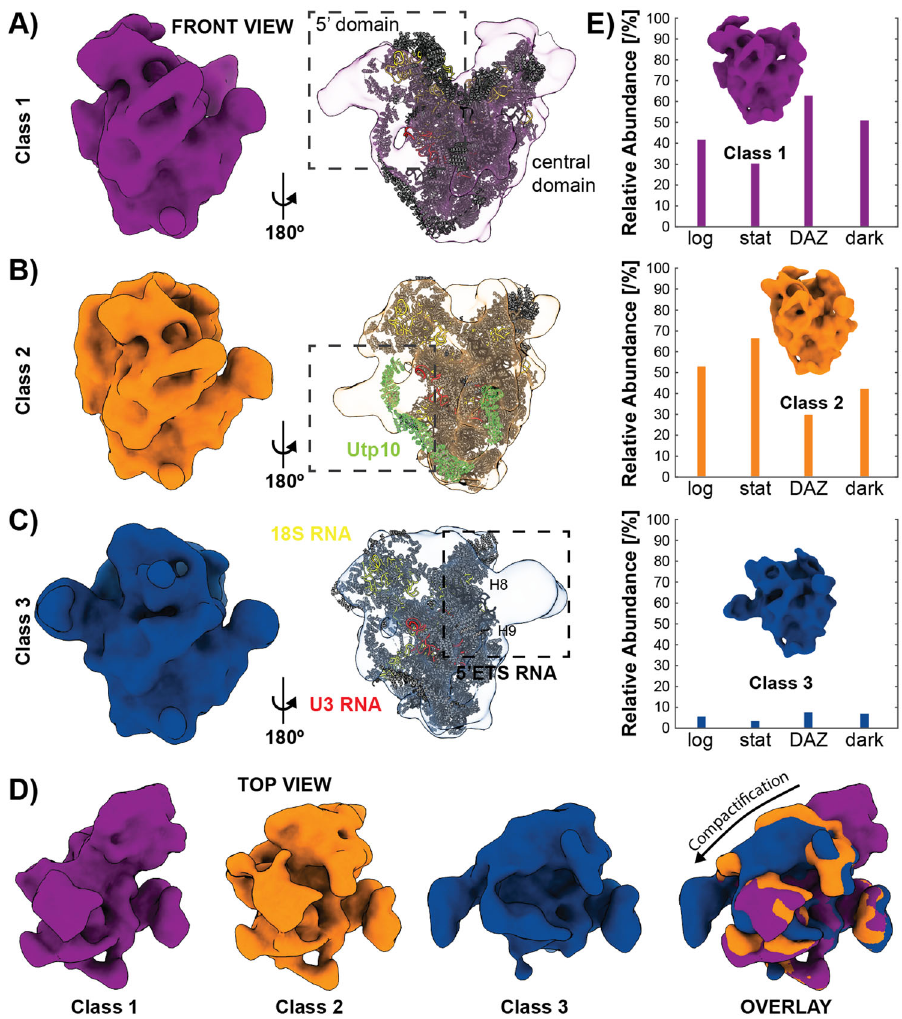
Fig. 3 Structural heterogeneity of in situ SSU processome particles. A – C Three distinct SSU processome class averages (Class 1 – 3) with different similarity to published structures are detected. D There is a clear trend from Class 1 to Class 3 toward a more compact arrangement of the 5 ′ and central domains. This is particularly evident when all three STA structures are aligned and superimposed, and indicates a sequence of maturation (Supplementary Movie 2). E The relative abundance of each class is subject to external stimuli. While Class 2 dominates during logarithmic (log) and stationary